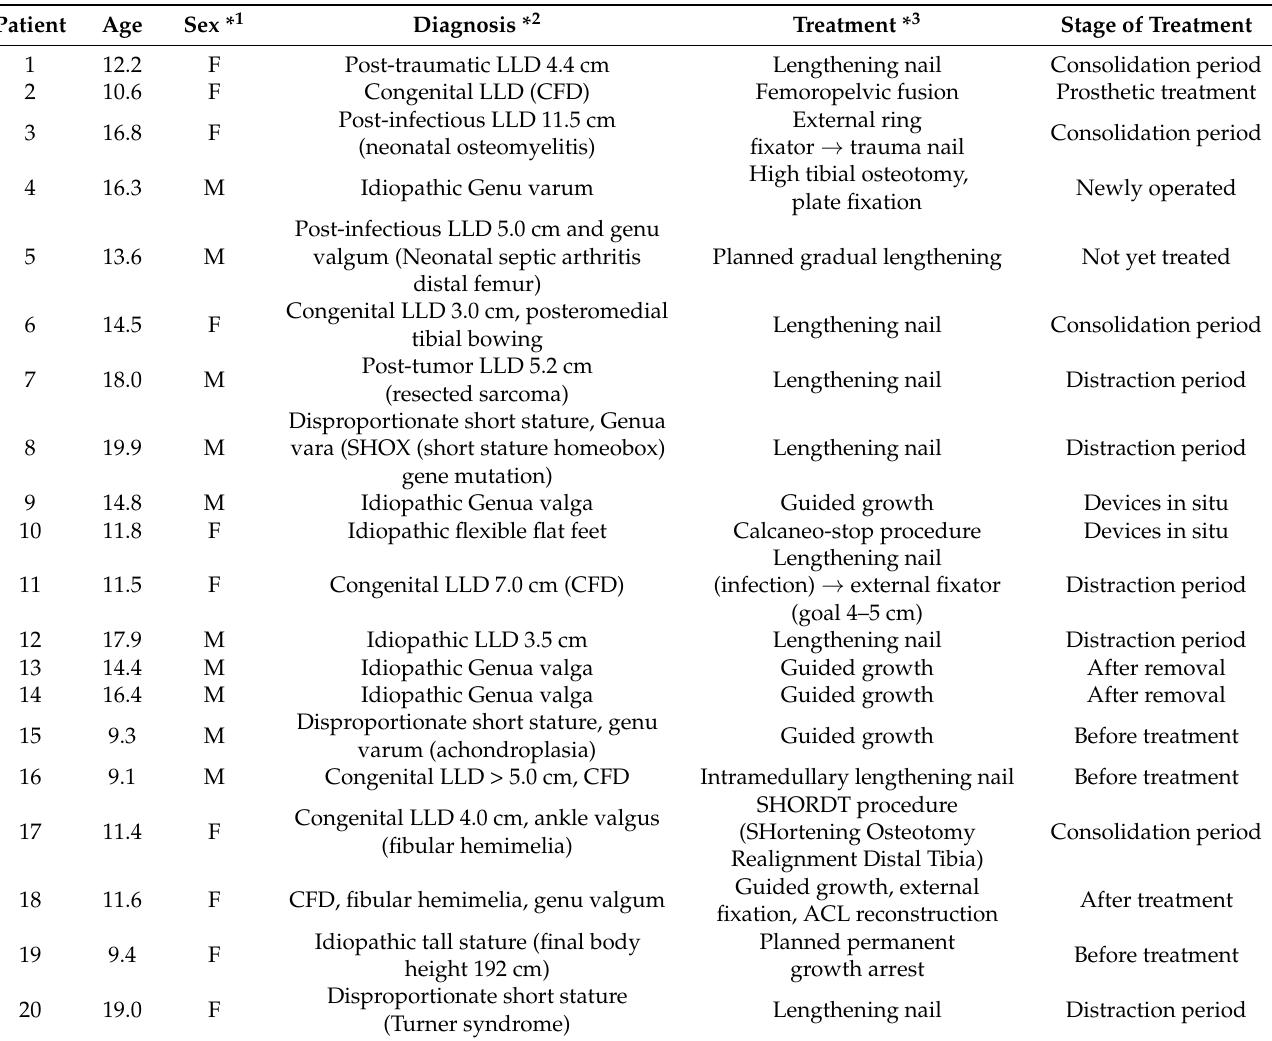
Table 1. Demographic data: patient’s age at the time of the interview, sex, diagnosed limb deformity, treatment, and treatment